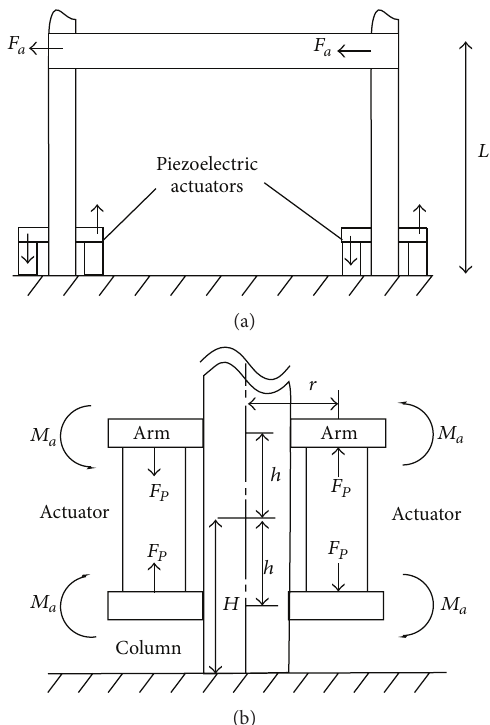
Figure 9: The piezoelectric actuator’s mechanism (a) front view and (b) side